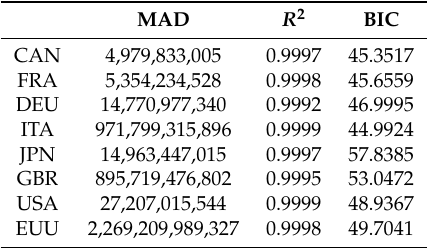
Table 5. Different values of neural